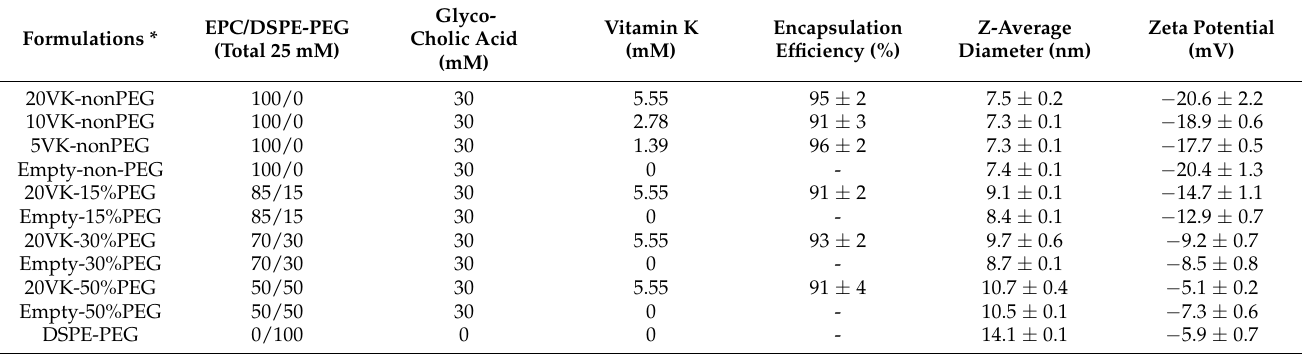
Table 1. Characteristics of mixed micelles with varying vitamin K loading and PEG content. Formulations